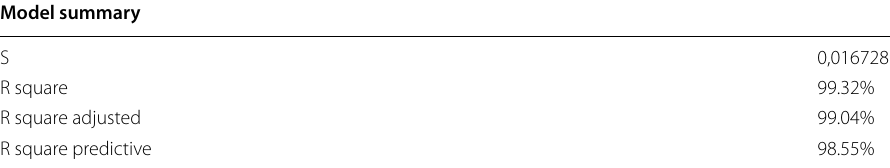
Table 4 Model summary